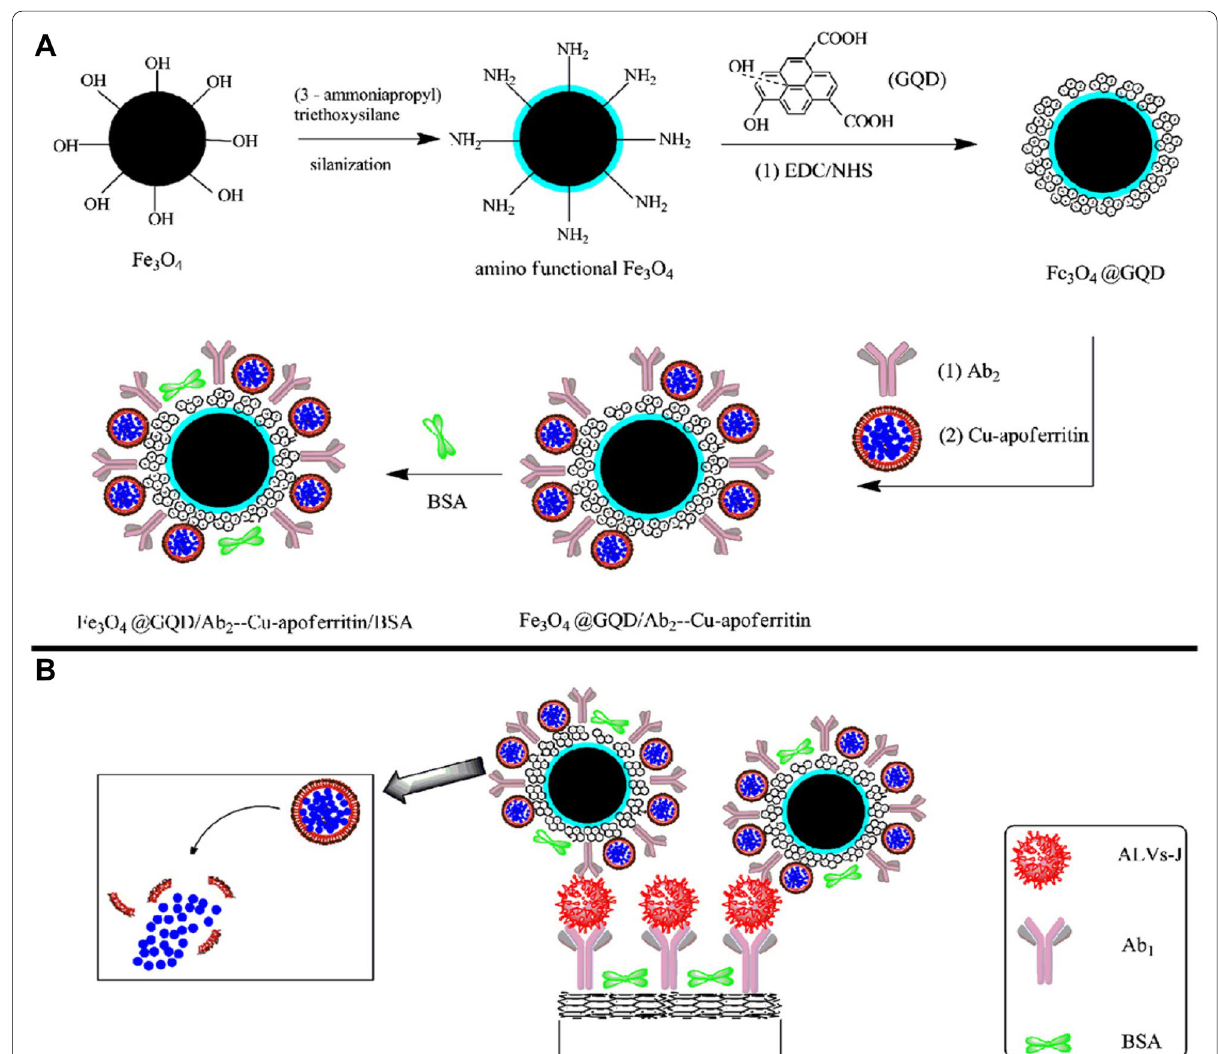
Fig. 7 Schematic representation of the construction of detection probe ( A ) and detection principle of GQDs-based nano system ( B ) [184]. Reproduced with permission. Copyright © 2013 Elsevier